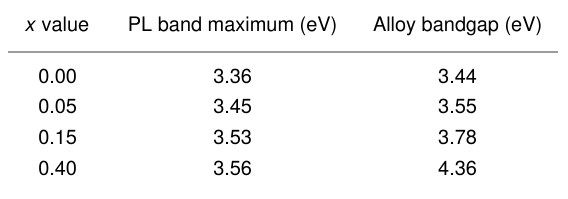
Table 2: The PL band spectral position and the bandgap value for ZnMgO films at 20 K. x value